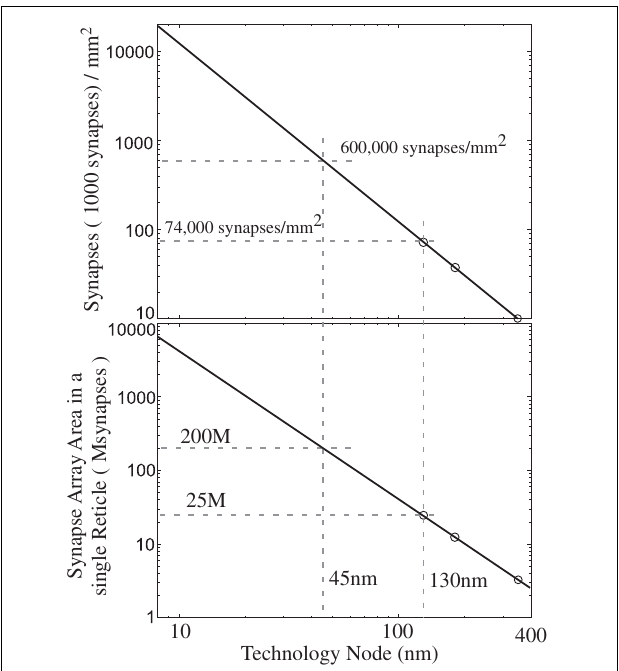
FIGURE 7 | Single-Transistor Learning Synapse density with process node. We plot both the synaptic density per mm 2 as well as total number of synapses per reticle, as well as data points from experimentally verified, floating-gate array of devices.